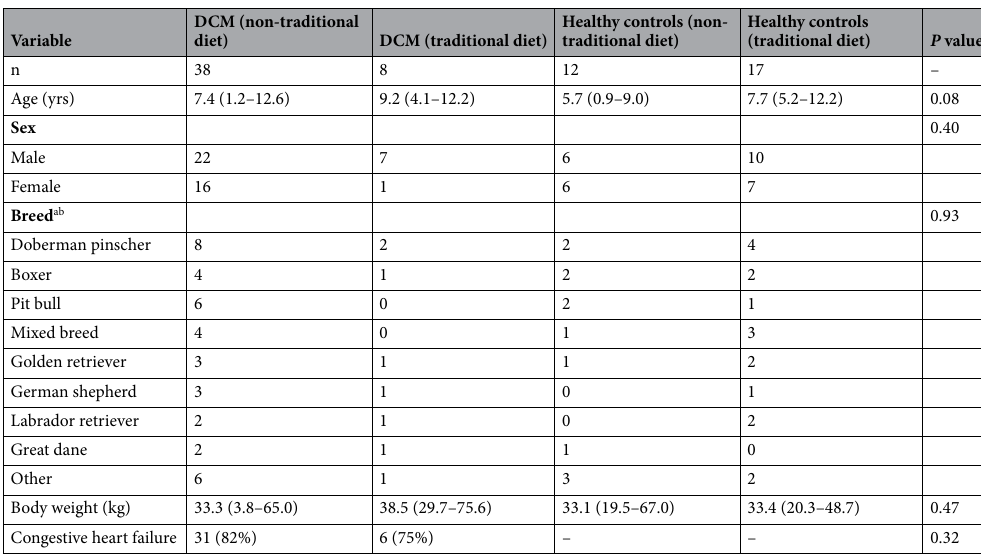
Table 1. Baseline characteristics of 75 dogs with dilated cardiomyopathy (DCM) and healthy controls eating non-traditional or traditional diets and in which metabolomic analyses were performed. a Other breeds included were English bulldog (n = 2) and 1 each of Akbash, Border collie, Briard, Catahoula Cur, Coonhound, Dalmatian, Irish wolfhound, Jack Russell terrier, Saluki, and standard poodle. b Dogs in the non-traditional diet group that survived to the 9-month follow-up visit included Doberman pinscher (n = 4), pit bull (n = 4), Boxer (n = 3), mixed breed (n = 3), golden retriever (n = 2), and 1 each of German shepherd, Irish wolfhound, Labrador retriever, and Standard Poodle. Dogs in the traditional diet group that survived until the 9-month follow-up visit included 1 Dalmatian and 1 Great